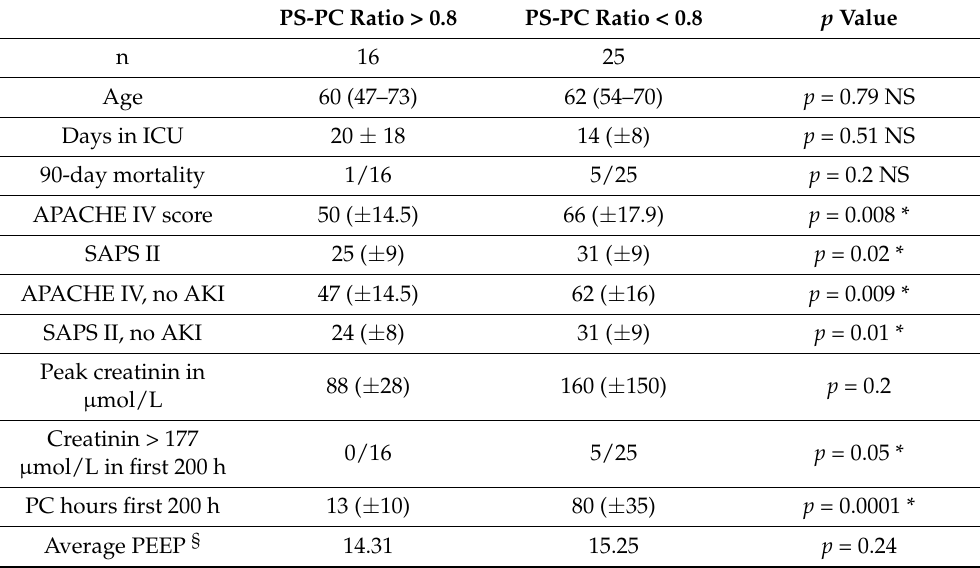
Table 1. Baseline characteristics of 41 patients undergoing invasive mechanical ventilation due to COVID-19 ARDS. Numbers represent the mean ± standard deviation.